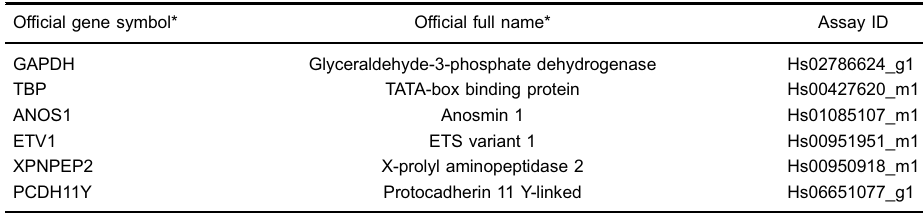
Table 1. Targets and housekeeping genes used in this study.